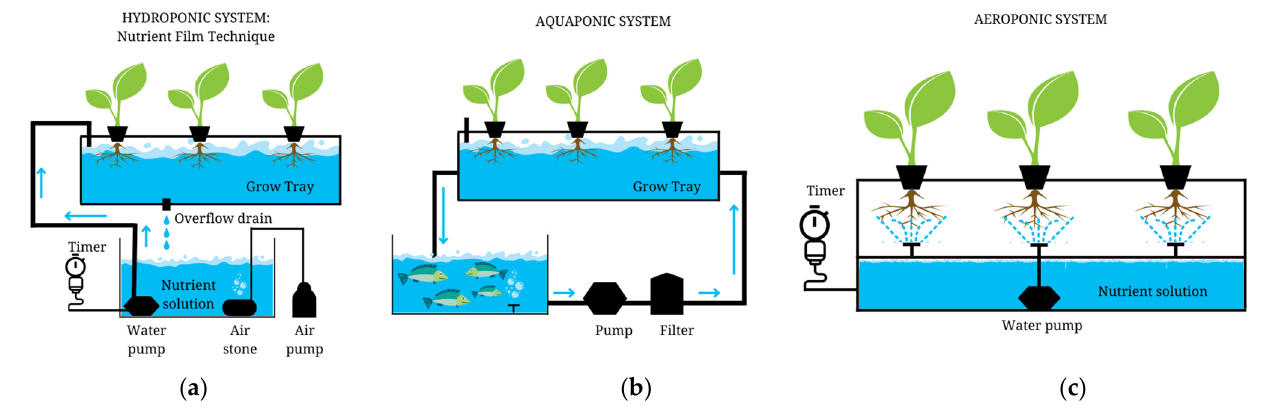
Figure 5. Hydroponic system ( a ), aquaponic system ( b ), and aeroponic system ( c ) . A basic representation of one-layer cultivation techniques (created with Canva.com, accessed on 10 February